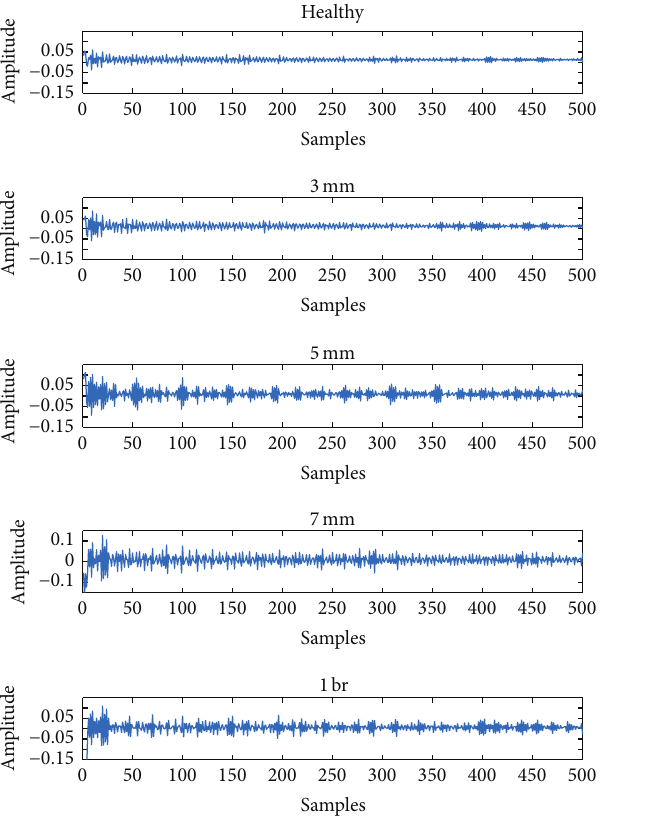
Figure 10: Approximation coefficients at half-mechanical load, 𝐴 𝑥 - axis.